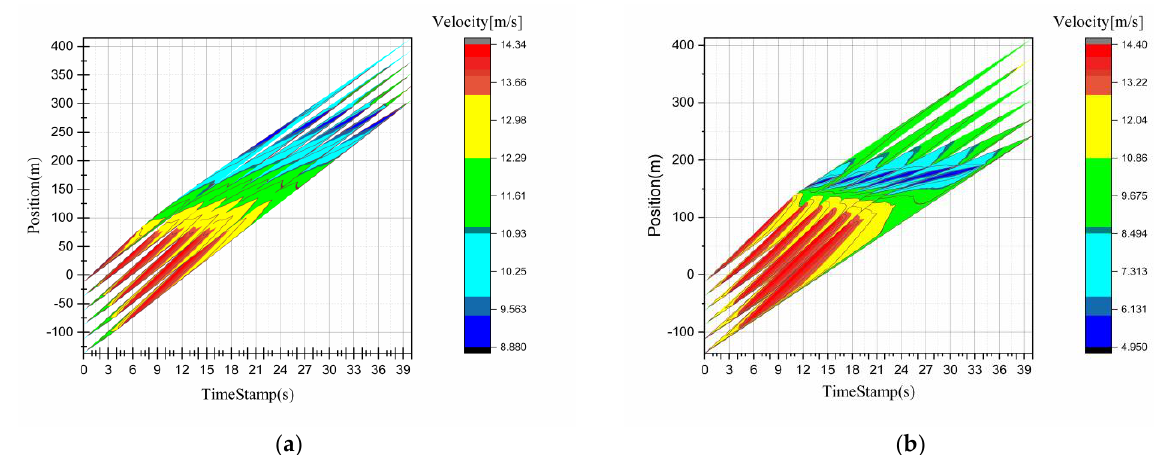
Figure 9. Velocity heatmap of CAVF fleet and CACCNF fleet under scenario 1: ( a ) CAVF velocity heatmap; ( b ) CACCNF velocity heatmap.